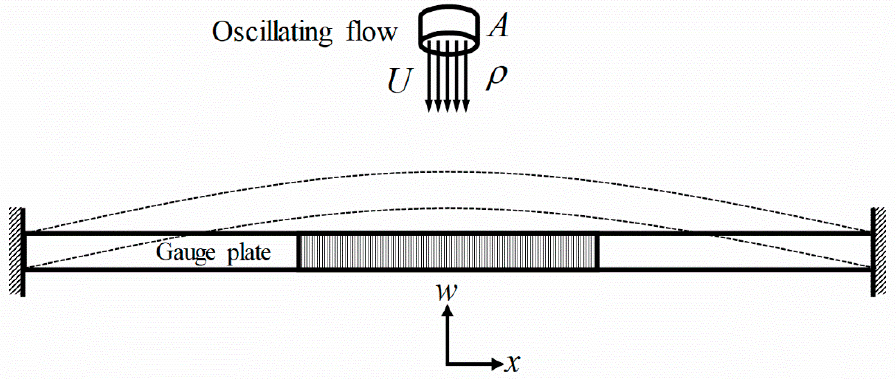
Figure 5. Diagram of excitation force modeling of flowing medium for analyzing vibration interaction between moving medium and the gauge plate restrained at both ends.